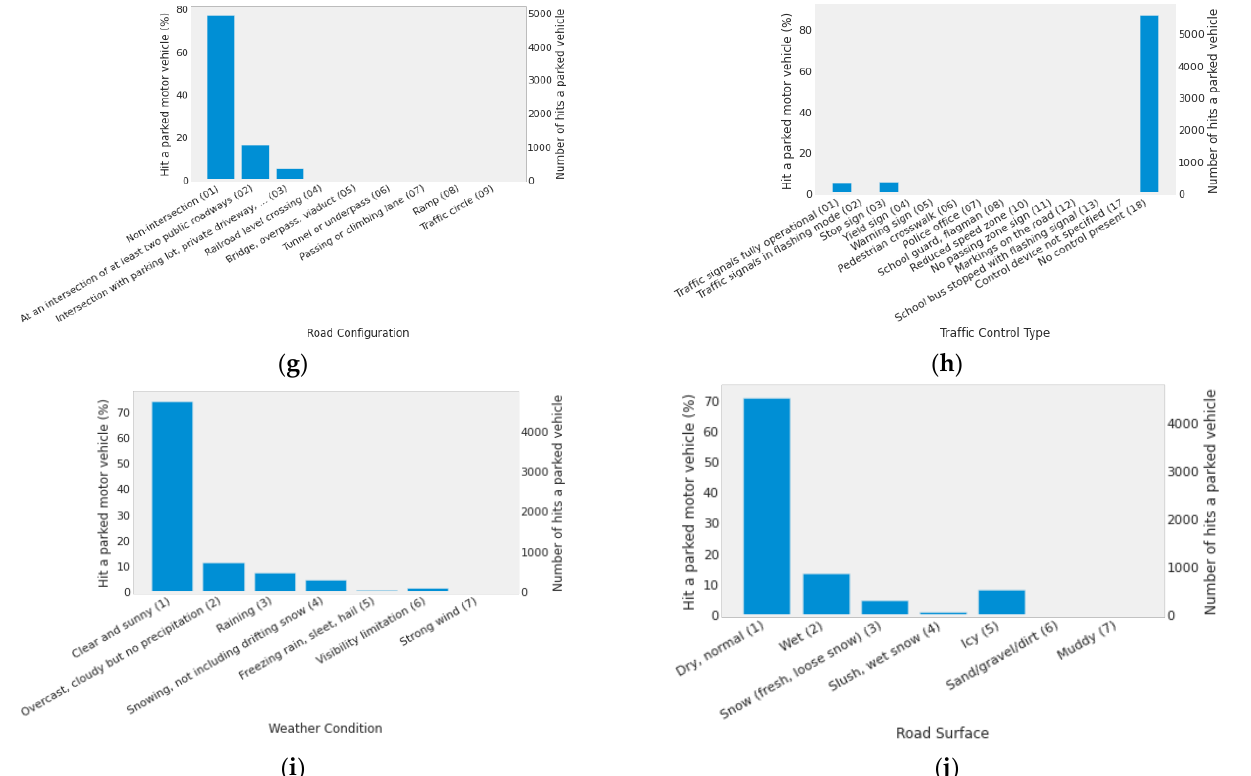
Figure 2. Distribution of collisions versus person or road level categories in hit a parked vehicle accident in NCDB dataset (1999–2017) [29]. (Number in parentheses shows the code for the category of the dataset).